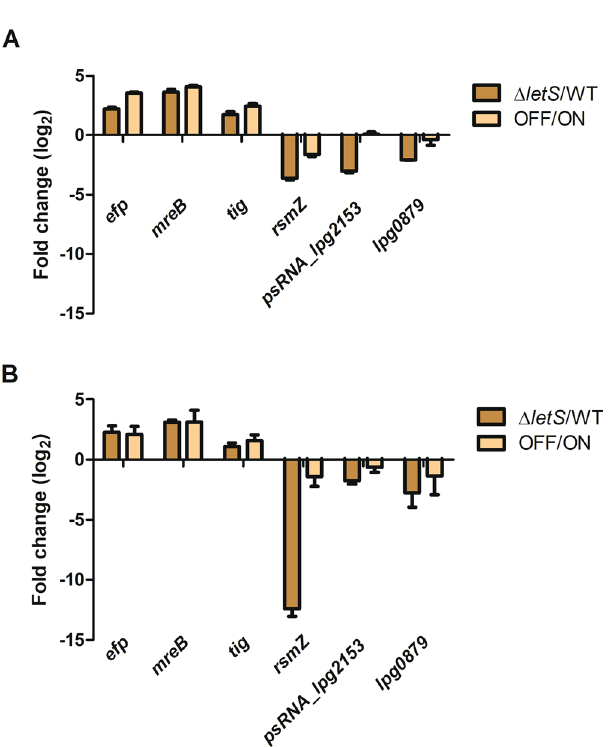
Figure 5. qPCR validates the DNA microarray analysis of the LetS regulon. RT-qPCR ( A ) was used to analyze the expression pattern of three up-regulated and three down-regulated genes in the transcriptomic analysis of WT vs . Δ letS ( B ). The fold change of each gene in the letS mutant ( vs . the WT) and the OFF strain ( vs . ON) are presented.